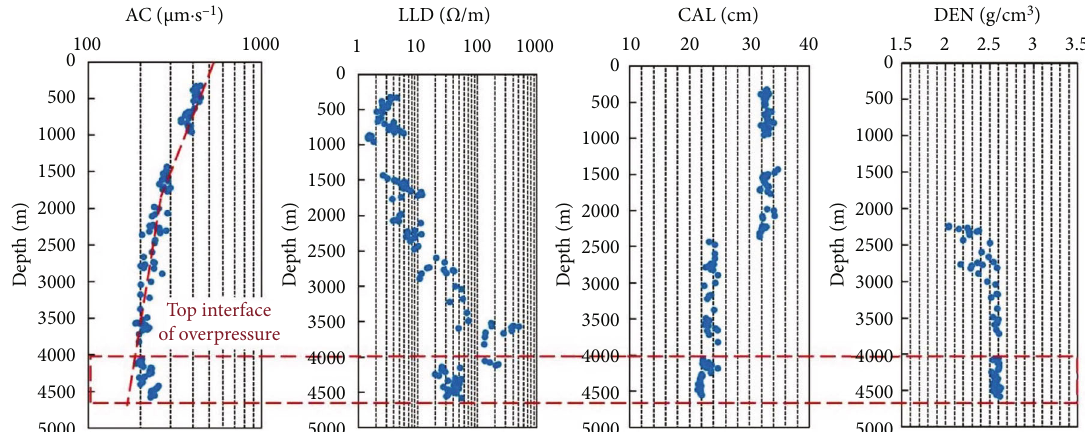
Figure 12: Curves of acoustic time di ff erence, resistivity, well diameter, and density of mudstone in well B212.